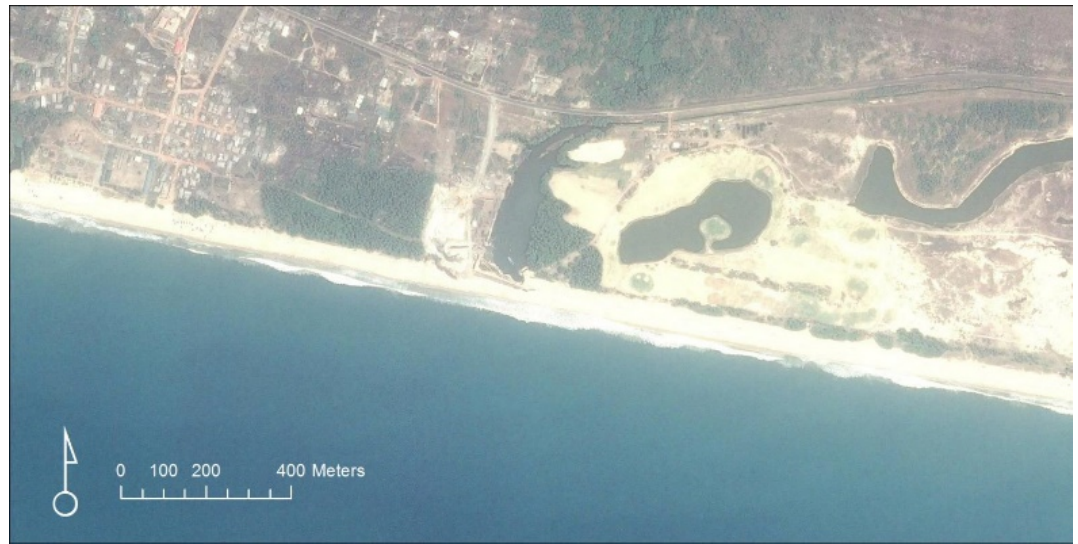
Water 2020 , 12 , x FOR PEER REVIEW